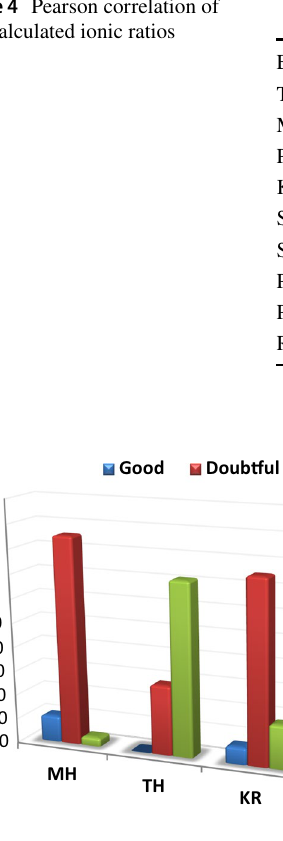
Fig. 6 Distribution of water quality